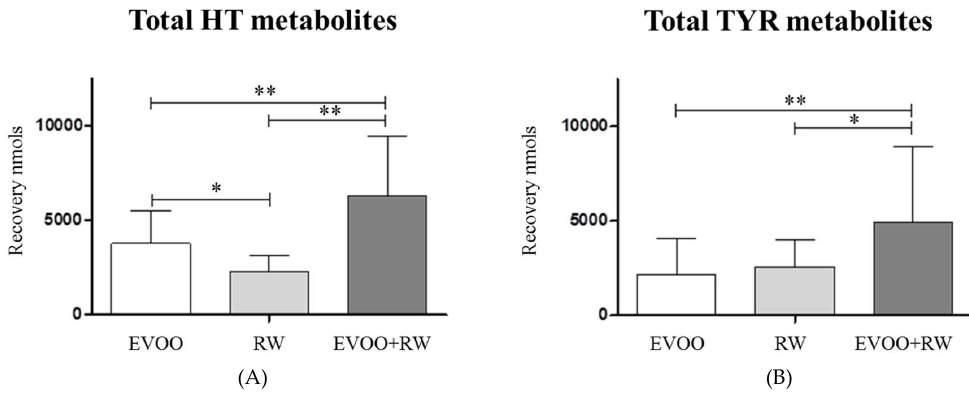
Figure 2. HT and TYR urinary recovery (nmol) from 0 to 6 h after EVOO, RW, and RW+EVOO ( n = 12) of ( A ) Total HT (HT-glucuronide + HT-sulfate + HT-acetate-sulfate + free HT + HVALc free + HVALc glucuronide) and ( B ) Total TYR (Tyrosol-glucuronide + TYR-sulfate + free Tyrosol). Data expressed as mean ± SD. * p < 0.05; ** p < 0.01. Table 3. HT, TYR, and metabolites urinary recovery (nmol) from 0 to 6 h after treatments.